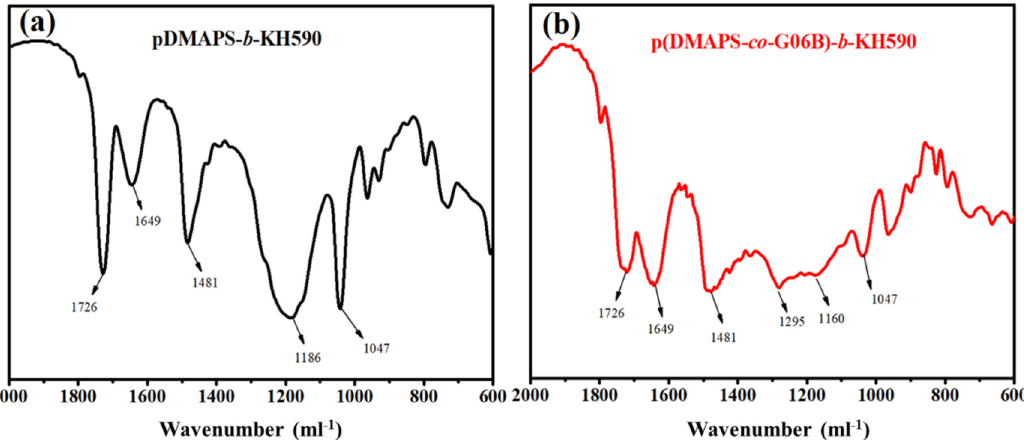
Figure 3. The FTIR spectrum of copolymer ( a ) PDMAPS + CoBF(40 ppm) (RUN 4); ( b ) PDMAPS + G06B + KH590 + CoBF(40 ppm) (RUN 5).